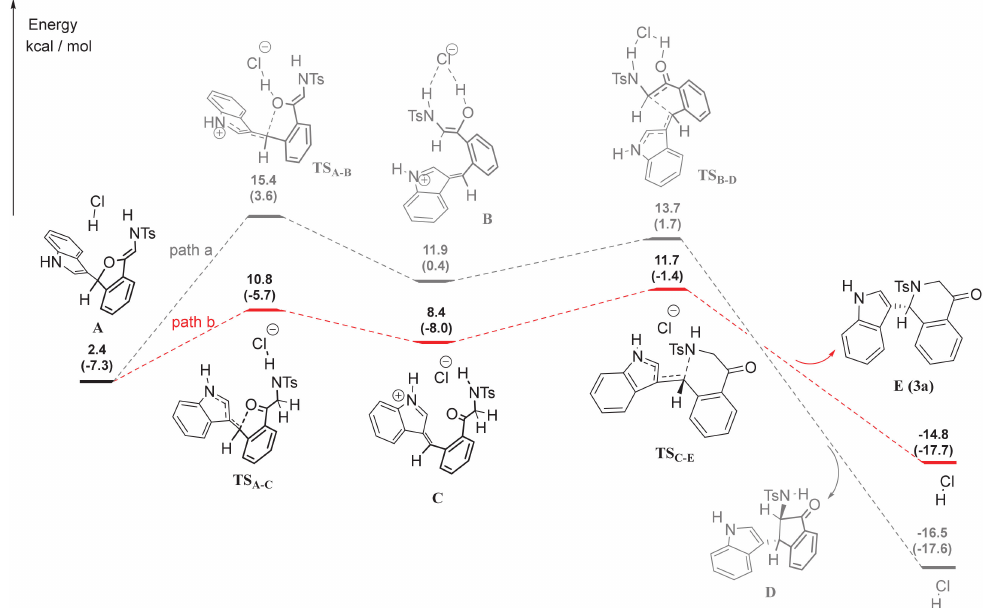
Figure 4. Detailed Reaction Meahanism by DFT Calculations. A, B and C were the possible intermediates, D and E were the possible